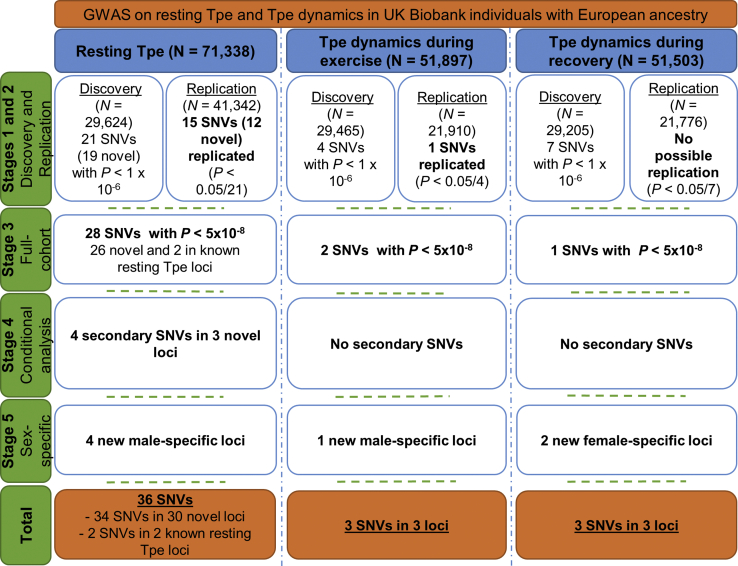
Analytical 5-Stage Approach FlowchartTpe, T-peak-to-Tend interval; SNV, single-nucleotide variant. Additional information can be found in Material and Methods.